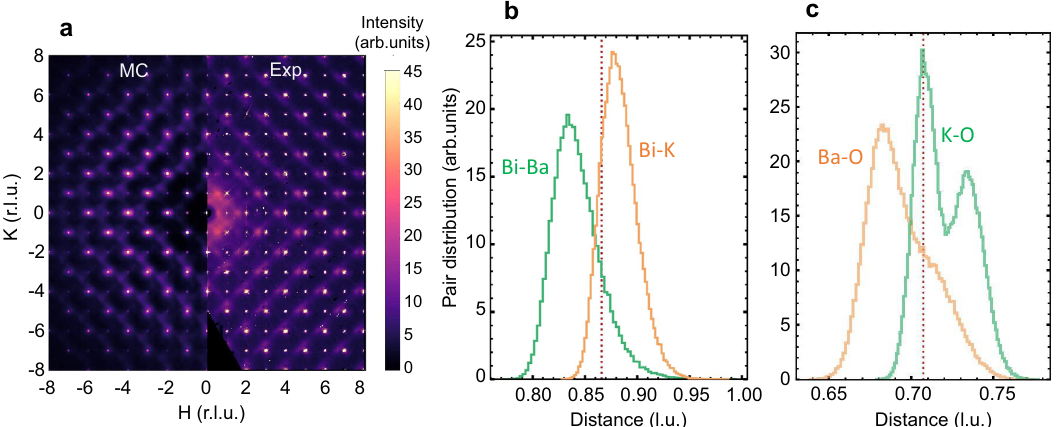
Fig. 3 | Monte Carlo modeling of the local structure. a Calculated reciprocal- space image (left half) from a simple model (see the “ Methods ” section) that only includes negative Bi – Ba and positive Bi – K correlations; r.l.u. refers to reciprocal lattice units. The model captures the main features observed in the experiment, in particularthediagonalrodsofscatteringandtheasymmetryofthediffuseintensity around Bragg peaks (right half). b Distribution of Bi – Ba and Bi – K distances within the model, showing a signi fi cant difference, which is the microscopic origin of the observed asymmetric diffuse features. Vertical dashed lines indicate the distances